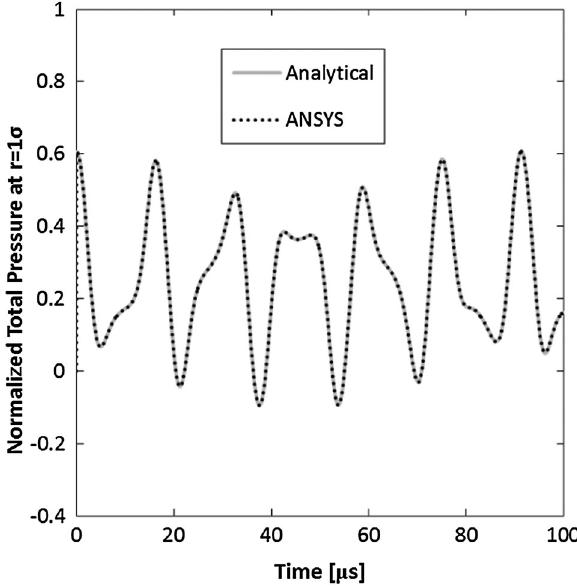
FIG. 5. Normalized total pressure at r ¼ σ for the test case assuming plane stress.